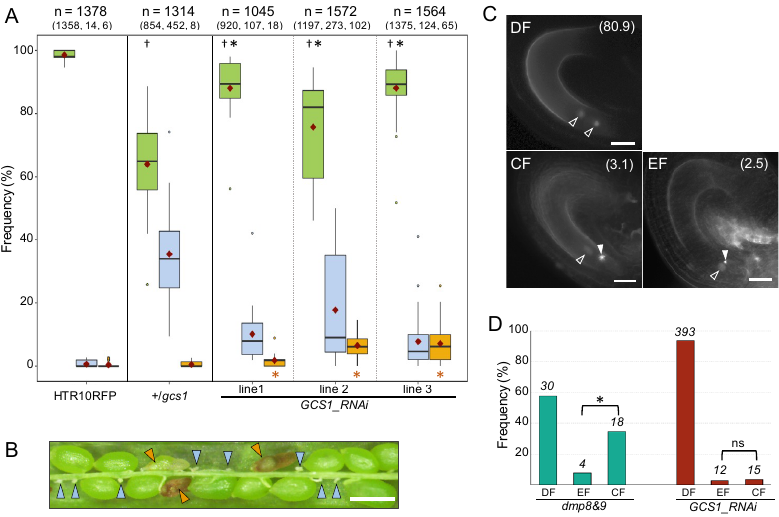
Figure 1. Fertilization failure observed in the GCS1 _RNAi plants. ( A ) Frequencies of each seed development phenotype observed in HTR10mRFP, +/ gcs1 , and GCS1 _RNAi T1 transgenic plants. Green, pale blue, and orange boxplots reflect normal, undeveloped, and aborted seed phenotypes, respectively. Seeds from 20–30 siliques were counted per plant. The numbers indicated at the top of each transgenic line are the total counts of the seeds (at 1st line) and each phenotype (at 2nd line in parenthesis). The horizontal bar and violet diamond on each boxplot represent the median and the mean, respectively. The dots associated with each boxplot represent the outliers in the counted data. The dagger and asterisk above the green boxplot represent the significant differences in normal seed phenotype relative to the HTR10mRFP and +/ gcs1 plants, respectively. The orange asterisks below each orange boxplot in GCS1 _RNAi lines represent the significant differences in the aborted phenotype relative to the +/ gcs1 plant. Significant differences were analyzed with the Wilcoxon rank-sum test ( p < 0.05). The p -values for all comparisons are shown in Table S2. ( B ) Abnormal seed development observed in the GCS1 _RNAi plant. Undeveloped and aborted seeds are marked with pale-blue and orange triangles, respectively. Non-labeled green seeds are the normal development phenotype. Bar = 0.5 mm. ( C ) The fertilization patterns observed in GCS1 _RNAi plant (line 2, T1–T3 plants). Open and filled triangles represent fertilized and arrested sperm cell nuclei signals, respectively. The numbers in parenthesis at the upper-right of the panel are the observed frequencies indicated in the graph in ( D ). DF: double fertilization; EF: egg cell fertilization; CF: central cell fertilization. Bar = 20 µm. ( D ) Frequencies of each fertilization pattern observed in the dmp8dmp9 and GCS1 _RNAi plant (line 2). The total number of the counted ovule is indicated in italics above each bar. Asterisks indicate the significant difference detected by the chi-square test ( p < 0.01). ns: not significant.